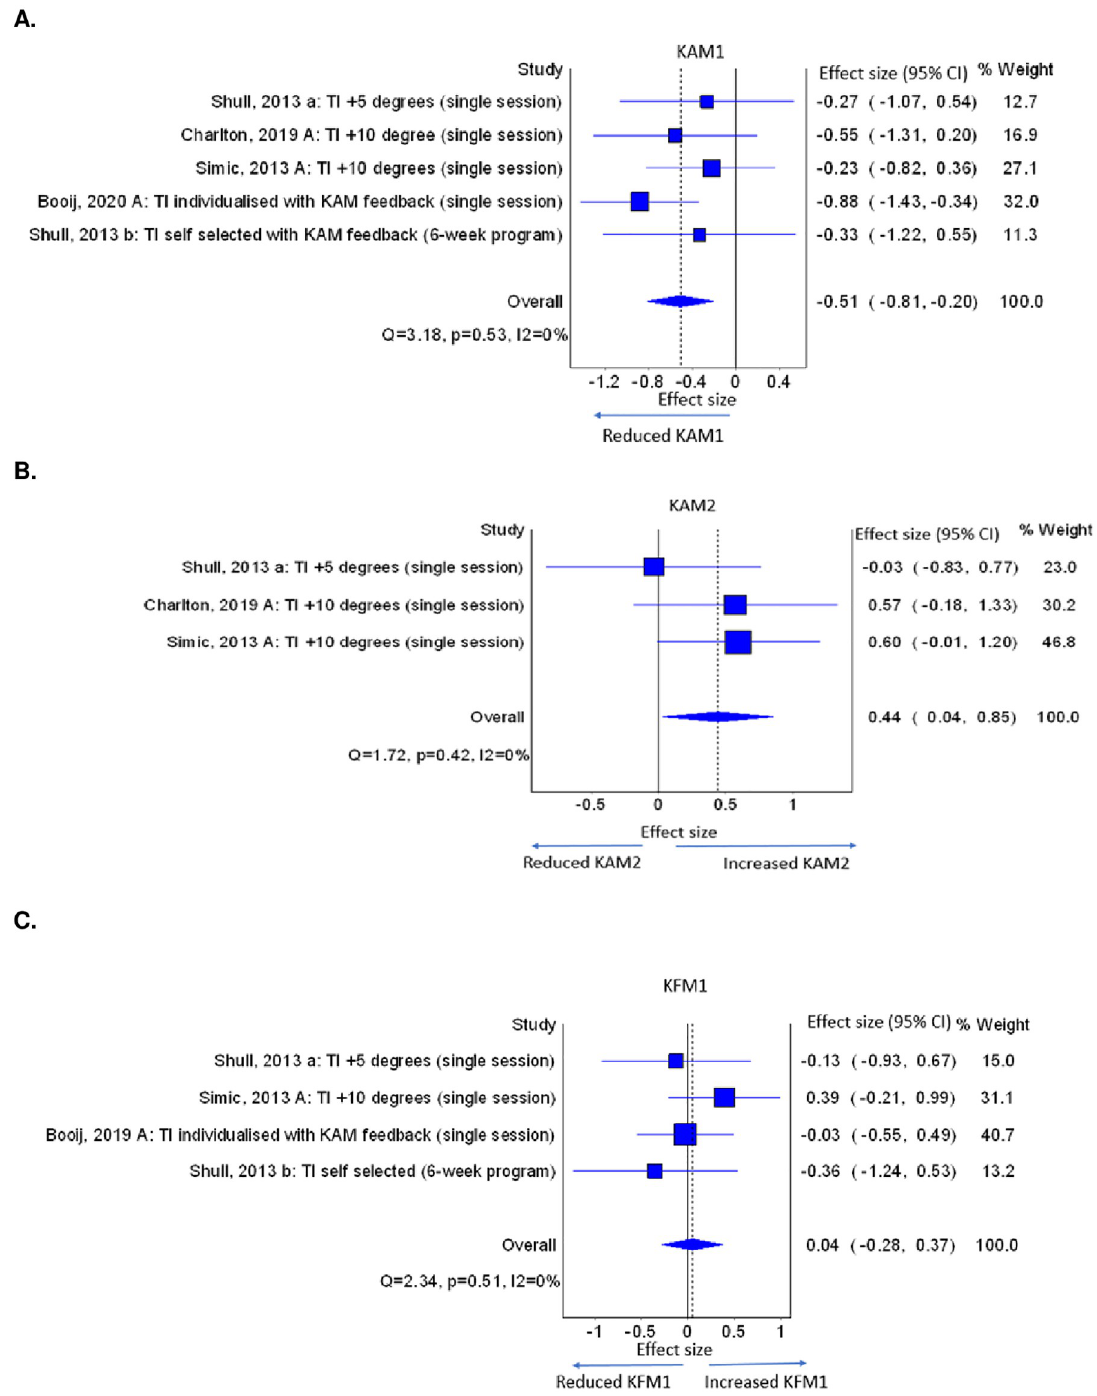
Fig 4. A. Effects of toe-in on KAM1, B. KAM2, C. KFM1 (TI: Toe-in, KAM1: early stance phase peak external knee adduction moment, KAM2: late stance phase peak external knee adduction moment, KFM1: early stance phase peak external knee flexion moment).